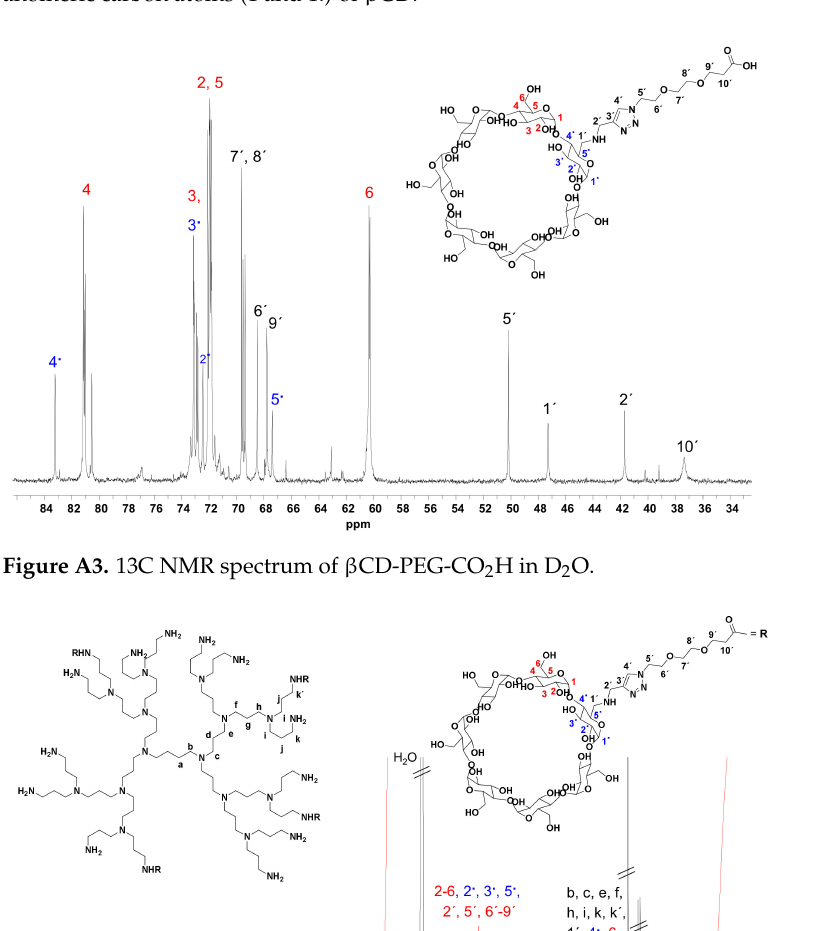
Figure A2. 13C NMR spectrum of β CD-PEG-CO 2 H in D 2 O. * unknown 1 H NMR signal next to anomeric carbon atoms (1 and 1.) of β CD.